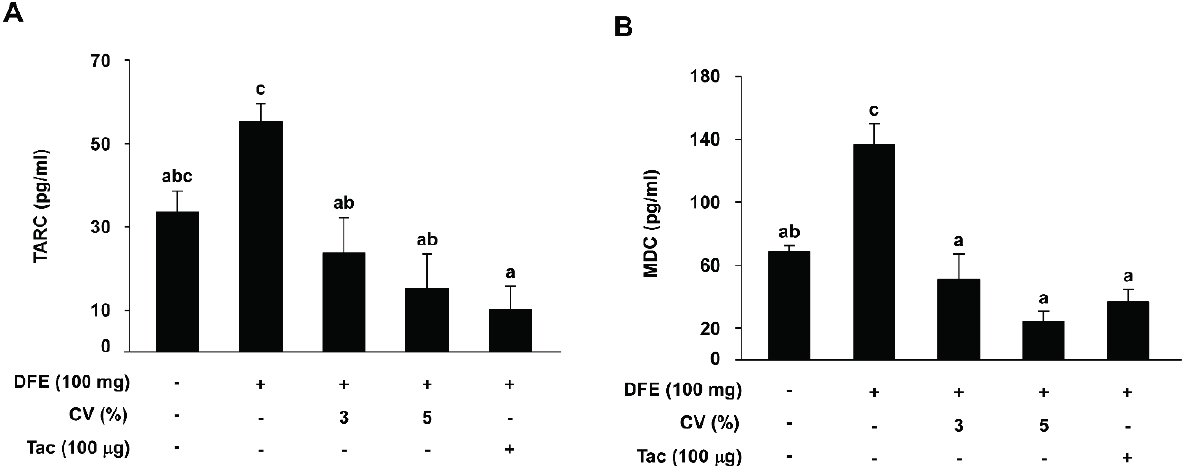
Figure 4. Effect of CV on DFE-induced increases in serum TARC and MDC levels in skin lesions. Levels of serum TARC ( A , n = 7–8) and MDC ( B , n = 7–8) were measured by ELISA. Data represent the mean values ± SEM ( n = 7). Mean values with letters (a–c) activation-regulated chemokine; MDC: macrophage-derived